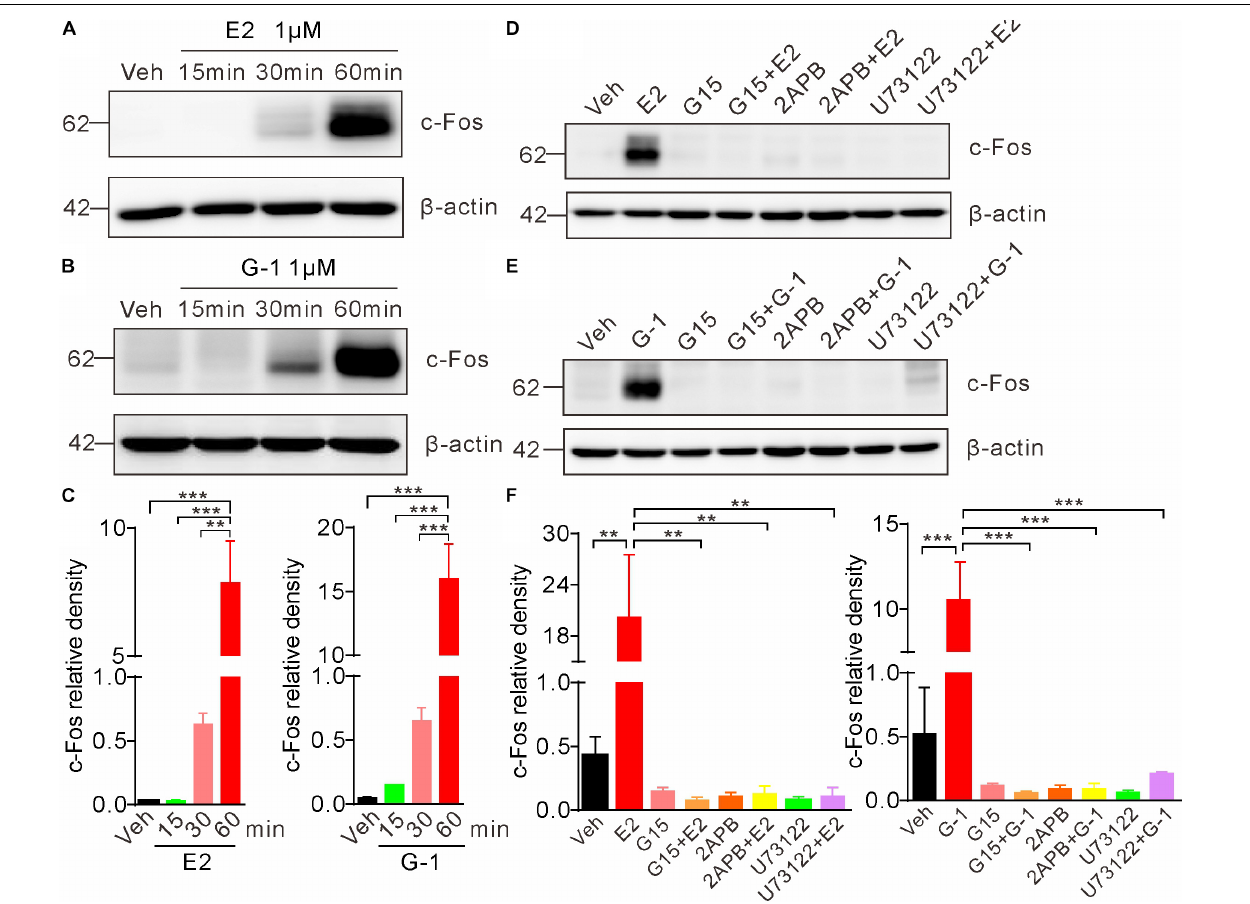
FIGURE 6 | Activation of GPER induces c-Fos expression in SH-SY5Y cells. (A–C) Cells treated with E2 (1 µ M) or G-1(1 µ M) showed time-dependent increases in c-Fos expression. (D–F) E2 and G-1-induced c-Fos expression was prevented by the GPER antagonist G15 (1 µ M), PLC inhibitor U73122 (1 µ M), and IP3R inhibitor 2-APB (1 µ M). c-Fos density was relative to β -actin. ∗∗ P < 0.05, ∗∗∗ P < 0.01, one-way ANOVA with Tukey’s post hoc test, averaged data from three independent